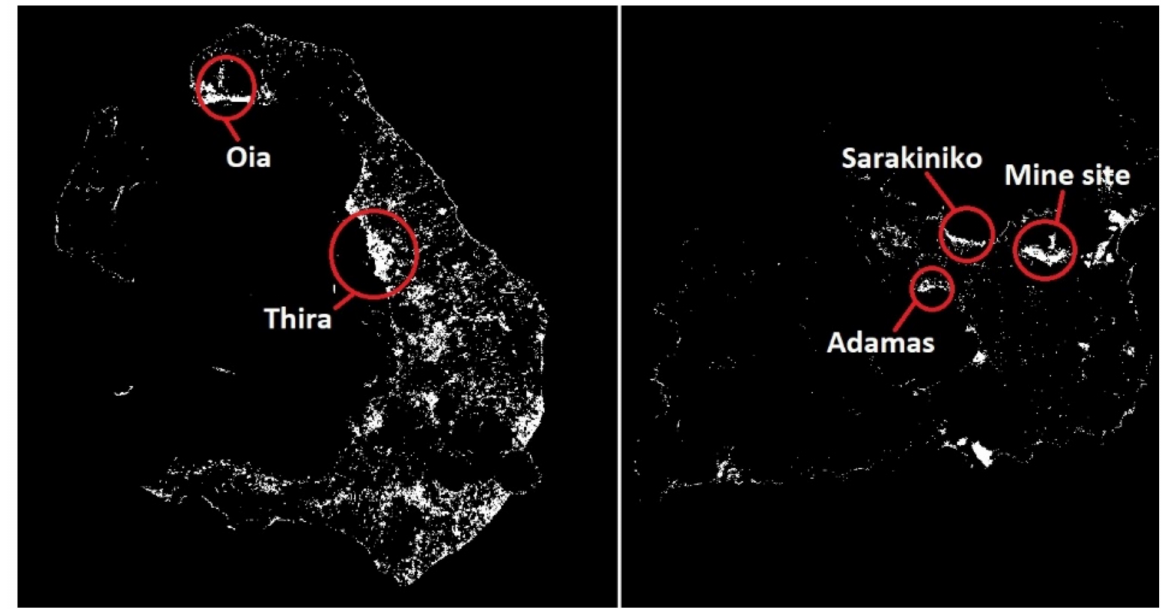
Figure 5. The image represents the false categorization of urban, open-pit mines and volcanic geological formations using the cloud mask in two study areas (left image: Thira; right image: Milos). The white color represents cloudy regions, while the black color depicts regions without clouds. The red circles highlight several examples of sites incorrectly classified as clouds.